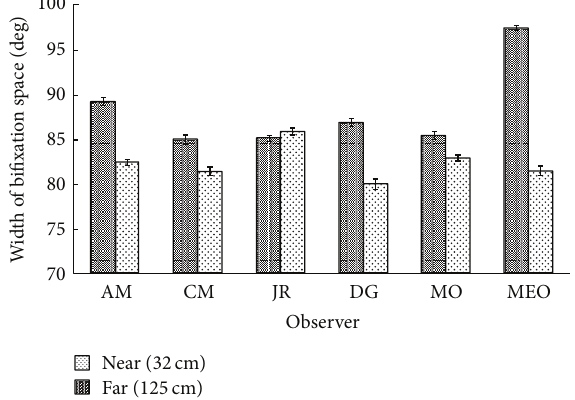
Figure 4: Mean width ( ± SEM) of the bifixation field as a function of convergence